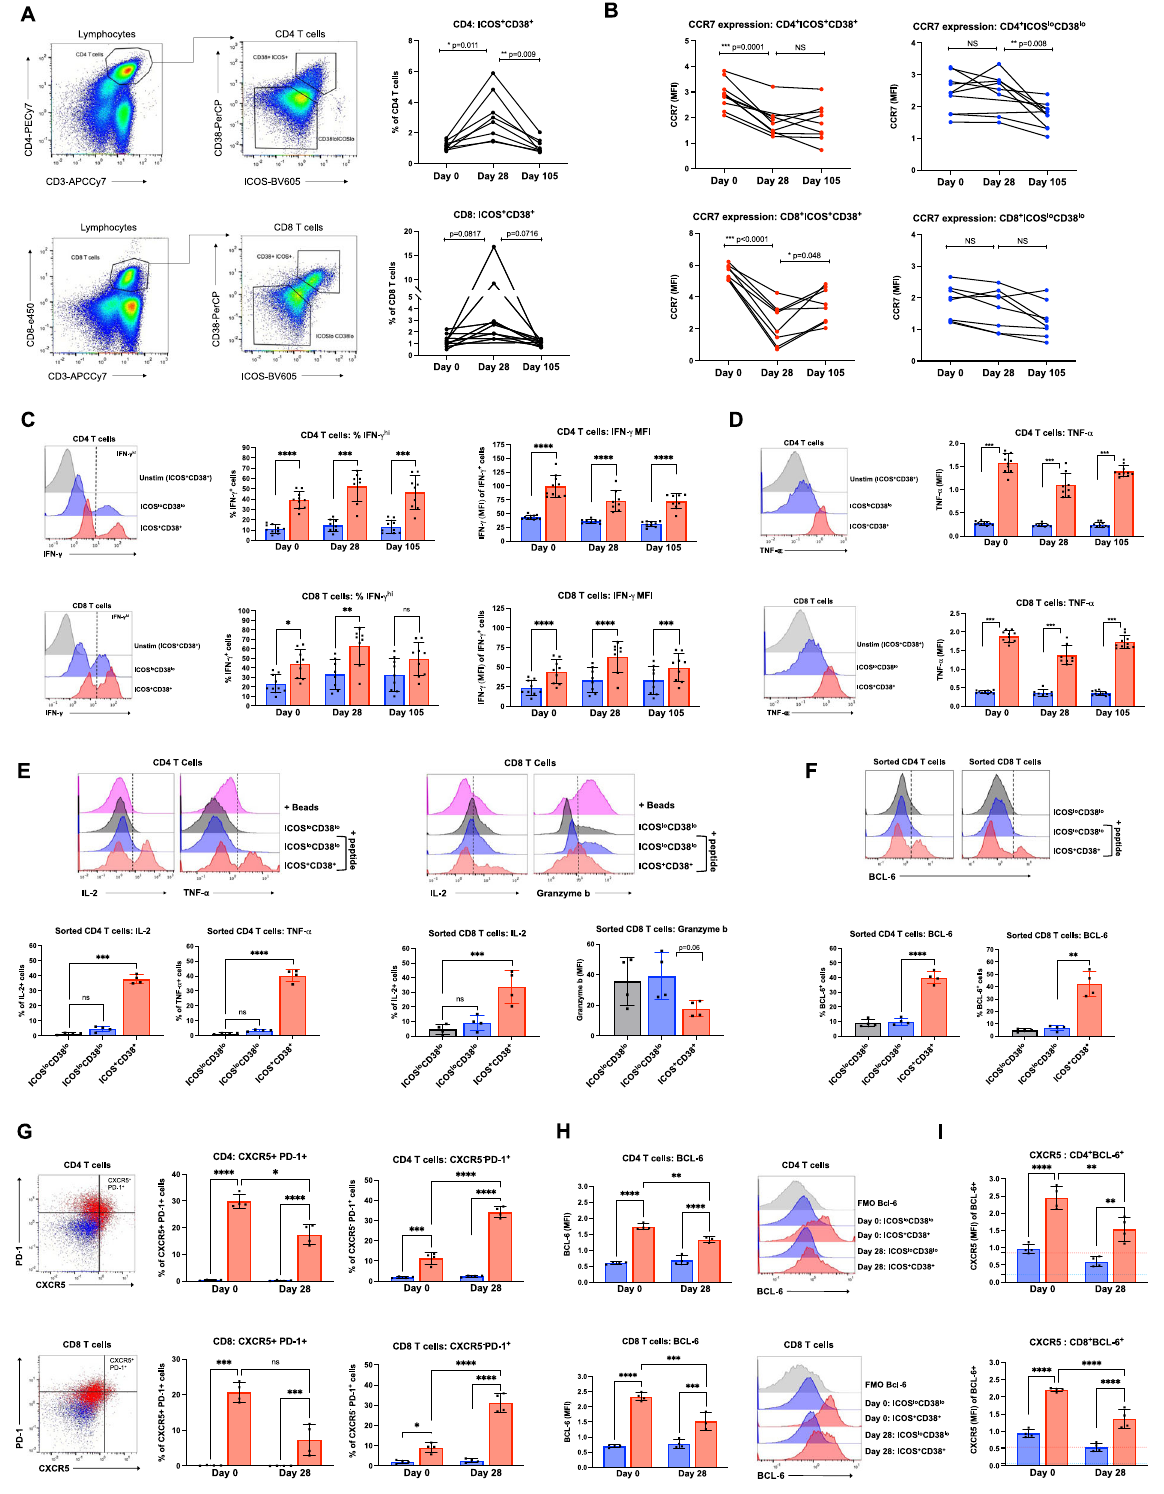
SARS-CoV-2 Alpha, HcoV-OC43, and HcoV-HKU1. Robust IgG responses were measured against SARS-CoV-2 Wuhan-1 by ELISA, with more varied IgM responses (Fig. 5A, Supplementary Fig. 5A). These patterns were generally consistent across the S proteins from circulating variants of concern Beta and